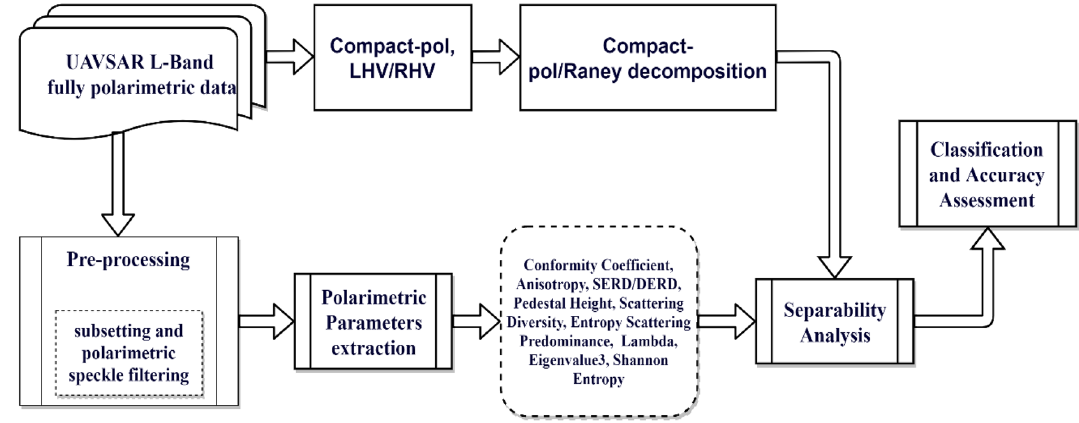
Figure 3. Flowchart of the proposed methodology for the study.